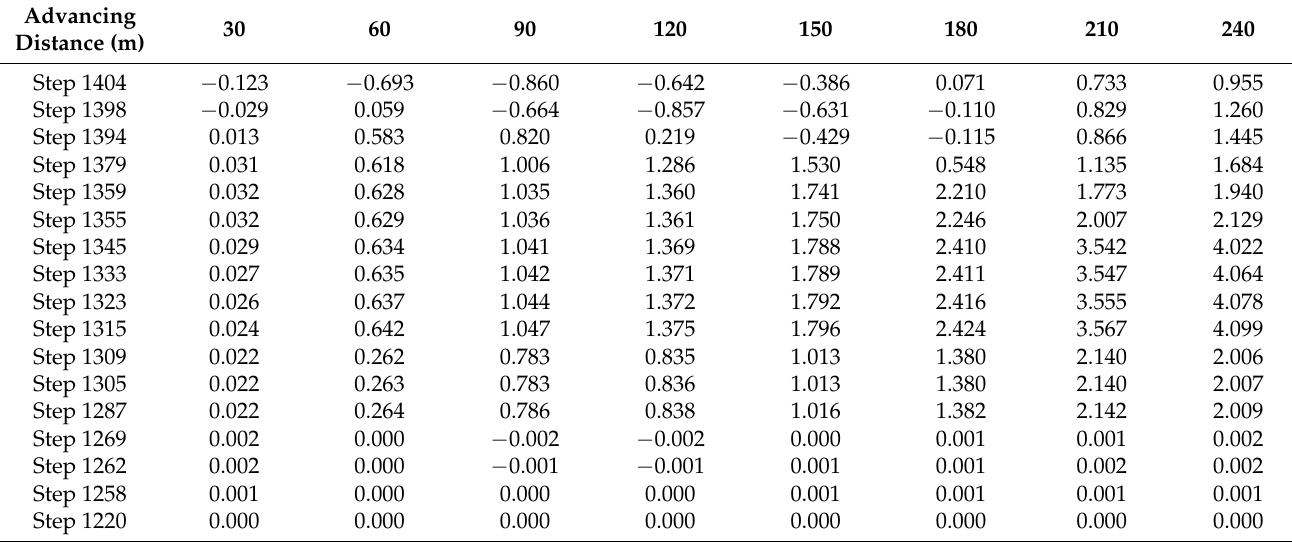
Table 2. Horizontal displacement of steps (m).